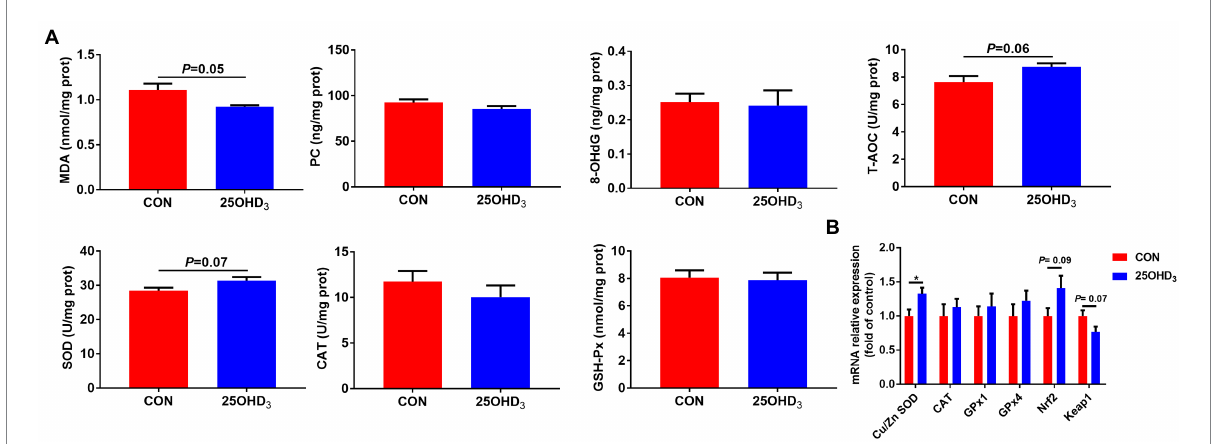
FIGURE 4 The antioxidant status and mRNA expression of antioxidant-related genes between the two treatments. (A) Antioxidant status in longissimus dorsi . (B) The mRNA expression of antioxidant-related genes in longissimus dorsi . Values are shown as the means ± SEM, n = 5. * p < 0.05 versus CON group. MDA, malonaldehyde; PC, protein carbonyl; 8-OHdG, 8-hydroxy-2 ′ -deoxyguanosine; T-AOC, total antioxidant capacity; SOD, superoxide dismutase; CAT, catalase; GSH-Px, glutathione peroxidase; Cu/Zn SOD, copper/zinc superoxide dismutase; GPx1, glutathione peroxidase 1;